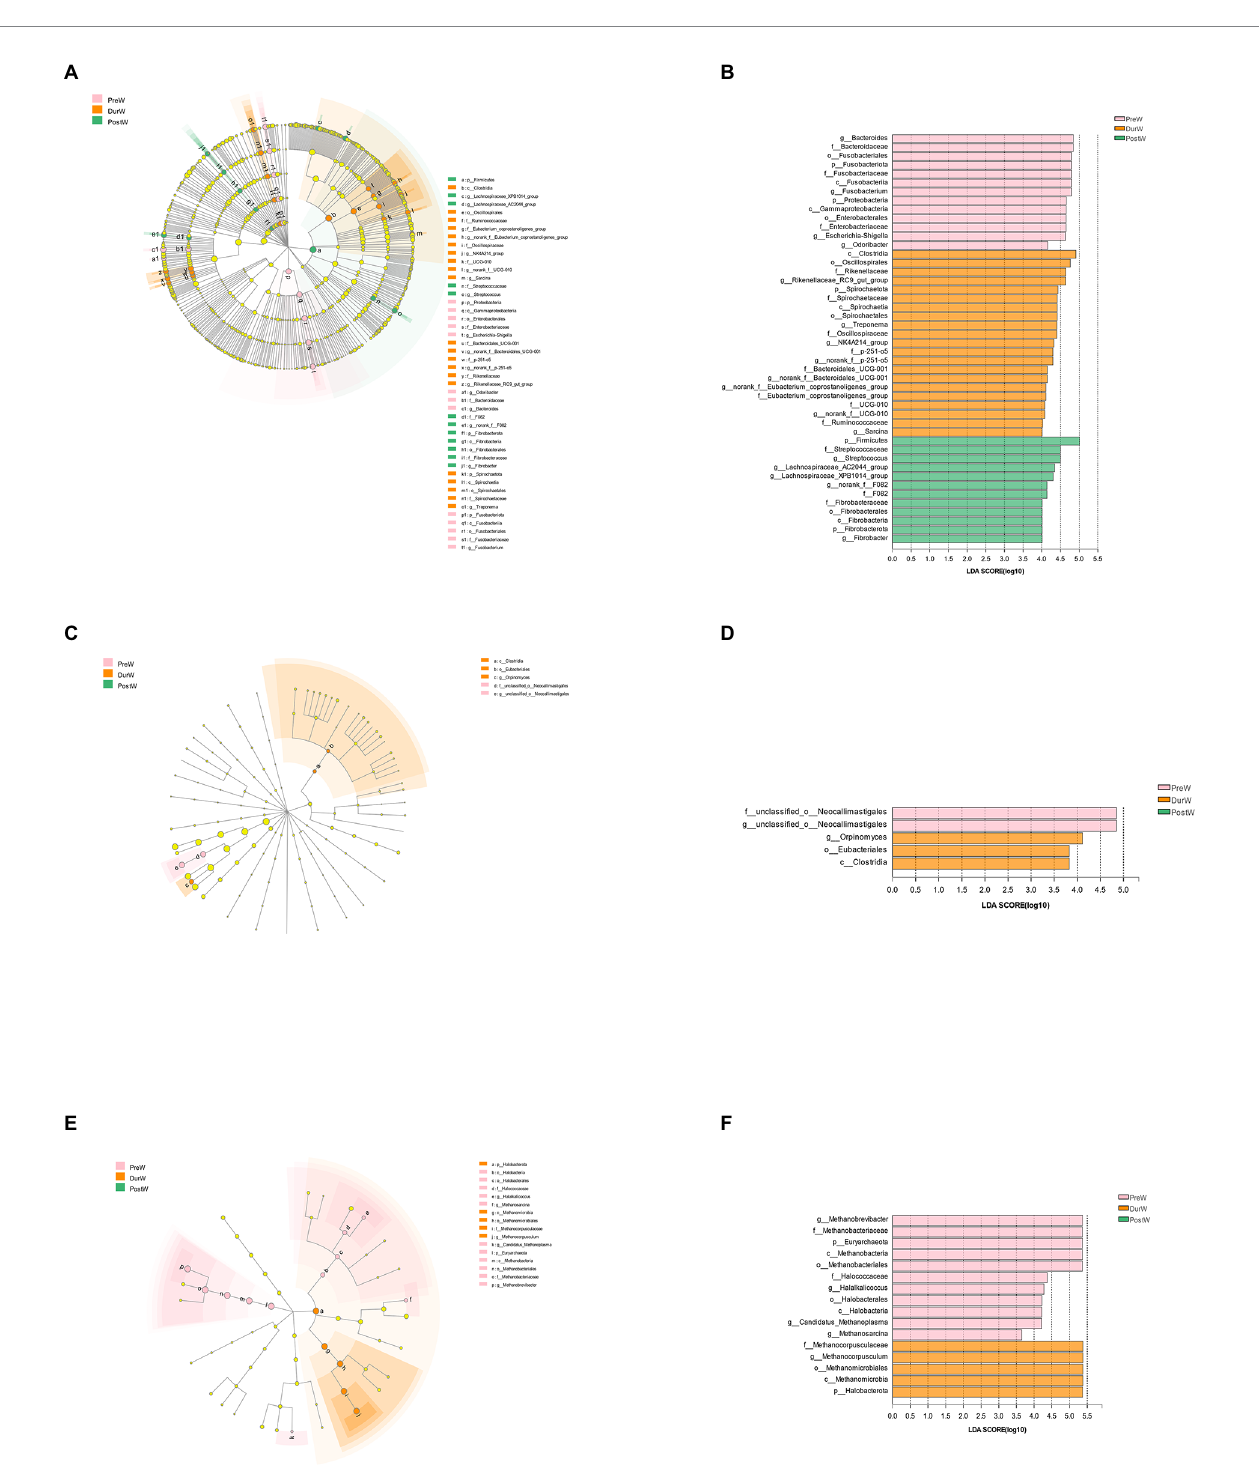
FIGURE 6 The LEfSe analysis showed the biomarkers of the microbial community in donkey foals during weaning period. The cladogram indicating the differences in relative abundance of taxa among PreW, DurW, and PostW groups; and the bar column shows the microbial taxa with significant differences among three groups (LDA score > 3). The length of the bar column represents the LDA score. (A) The cladogram of bacteria. (B) The LDA plot of bacteria. (C) The cladogram of anaerobic fungi. (D) The LDA plot of anaerobic fungi. (E) The cladogram of archaea. (F) The LDA plot of archaea; PreW, pre-weaning donkeys; DurW, during weaning donkeys; PostW, post-weaning